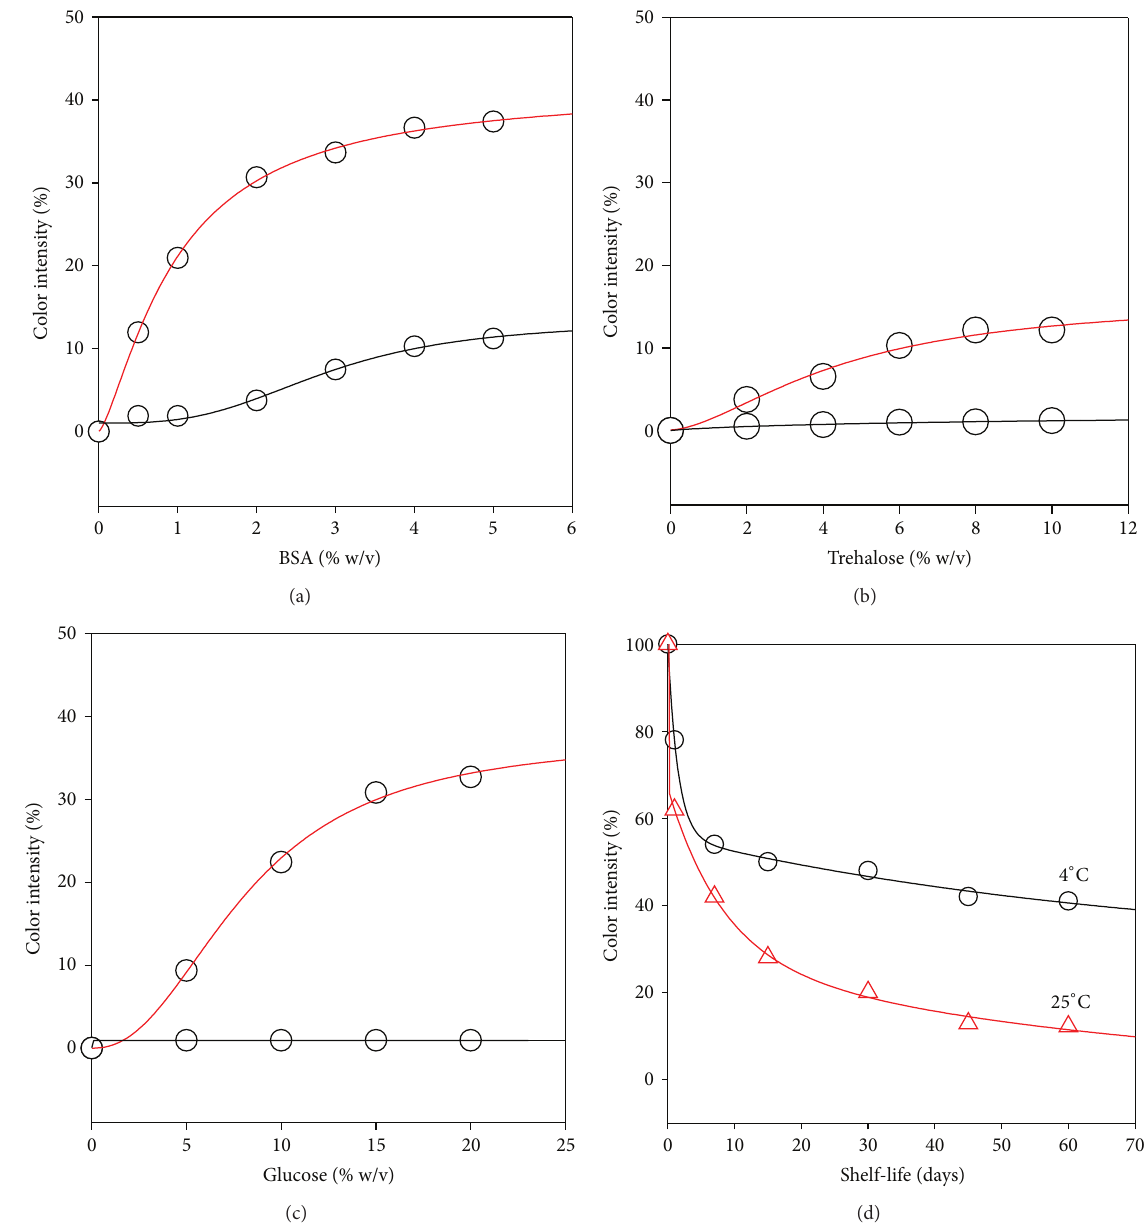
Figure 5: Effect of (a) BSA, (b) trehalose, (c) glucose, and (d) temperature on ChE activity. For (a), (b), and (c), black line is the color intensity for reaction mixture without enzyme, and red line is color intensity for reaction mixture with the